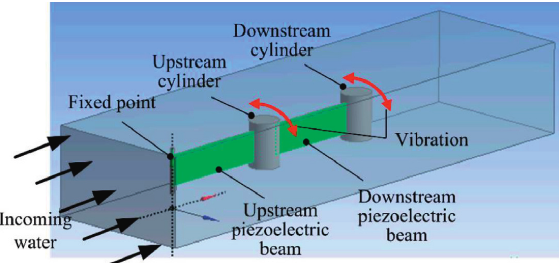
Figure 15: The energy harvester with two serial cantilever beams and cylinders